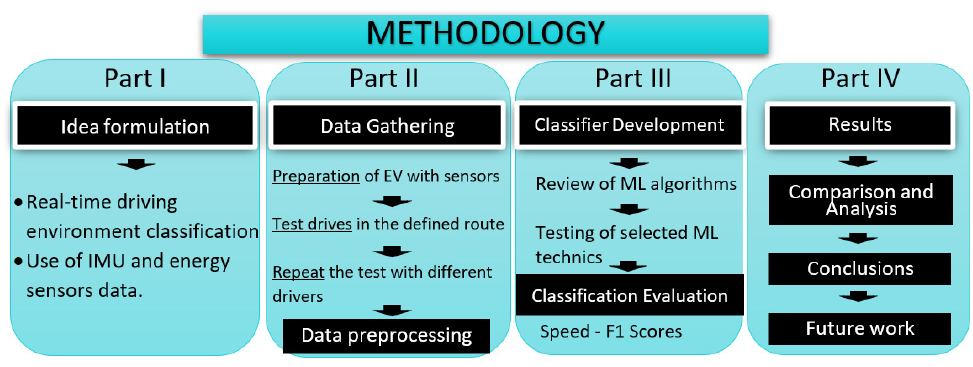
Figure 2. Design methodology of the EDS.